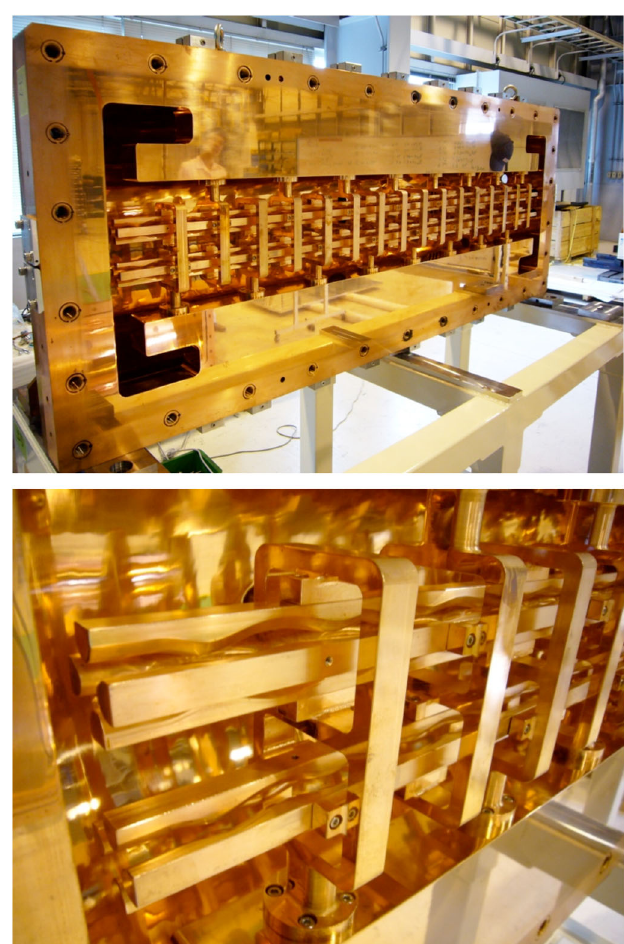
FIG. 20. A photo of the two-beam IH-RFQ